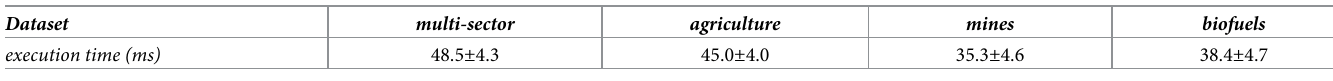
Table 4. Execution time of LurkerRank (milliseconds) on the different land trade networks (mean and standard deviation over 50 runs).